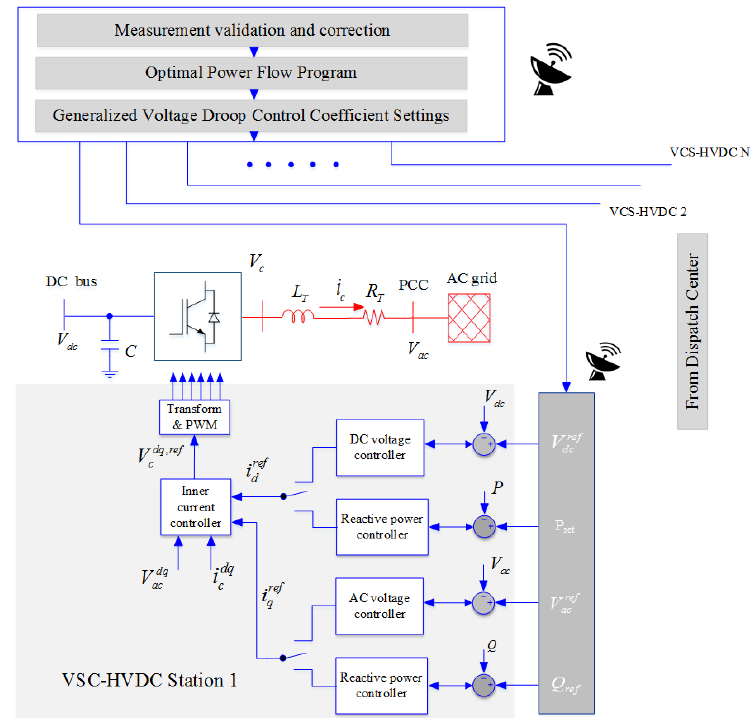
Figure 5. Droop control using d-q control.